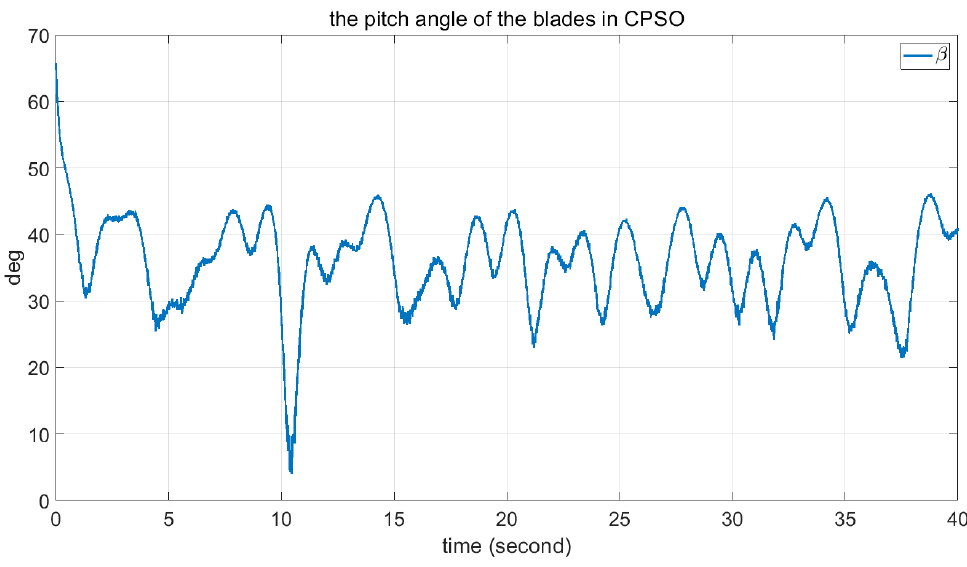
Figure 10. The angle of blades in CPSO. Example 2. The proposed FPSO approach .